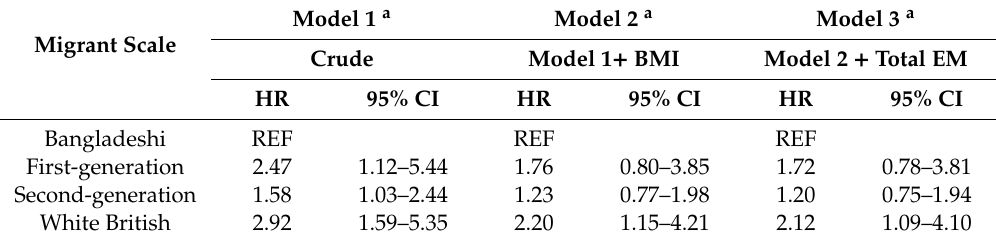
Table 4. E ff ect of EM on the association between migrant scale and risk of thelarche among British and Bangladeshi girls 5–16 years of age, ABBY Project, includes sample with EM ( n =